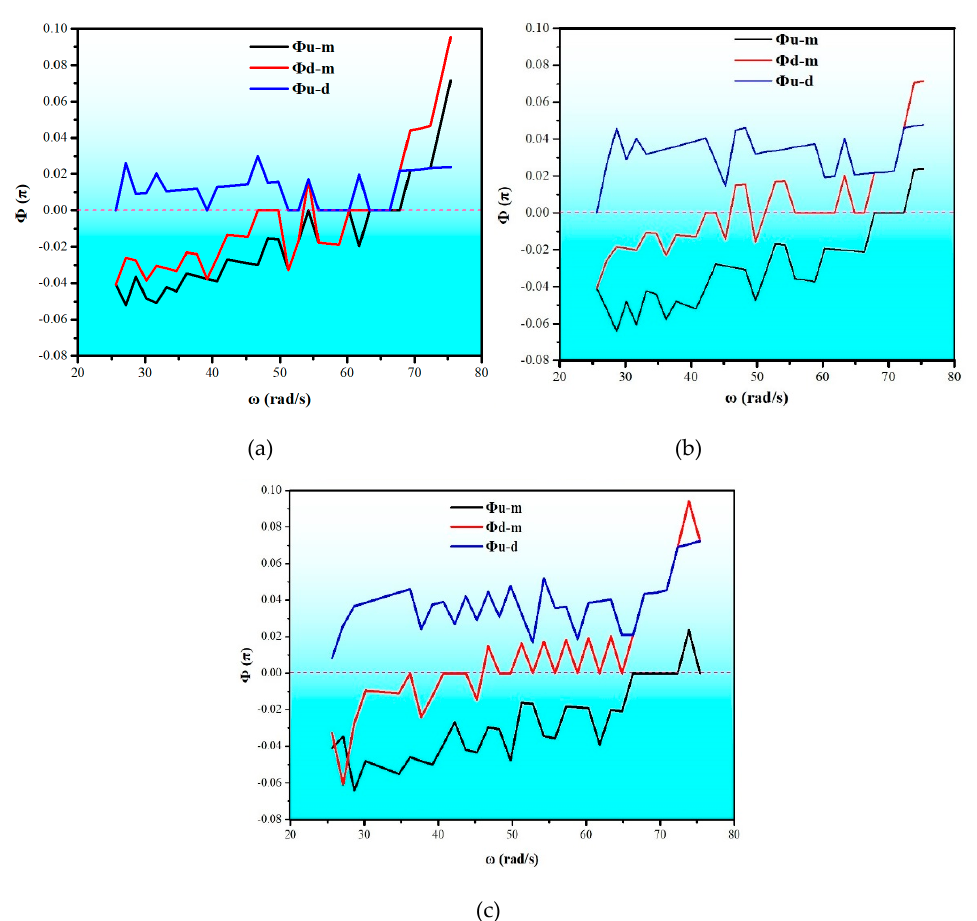
Figure 13. Influence of stiffness changing on the phase − frequency characteristic curves: ( a ) 12, 13; ( b ) 14, 14 and ( c ) 15, 13.